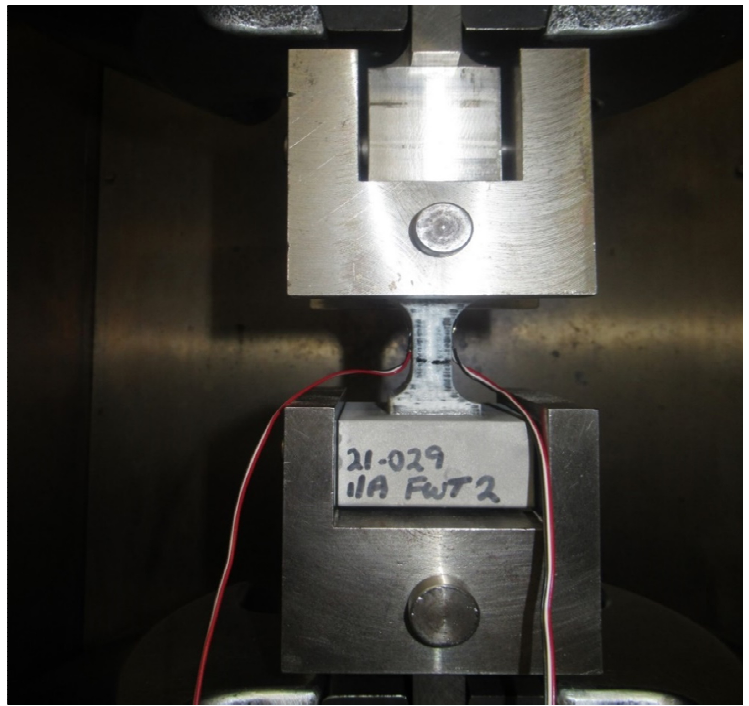
Figure 7. Sample test setup to calculate elastic modulus with two strain gauges.